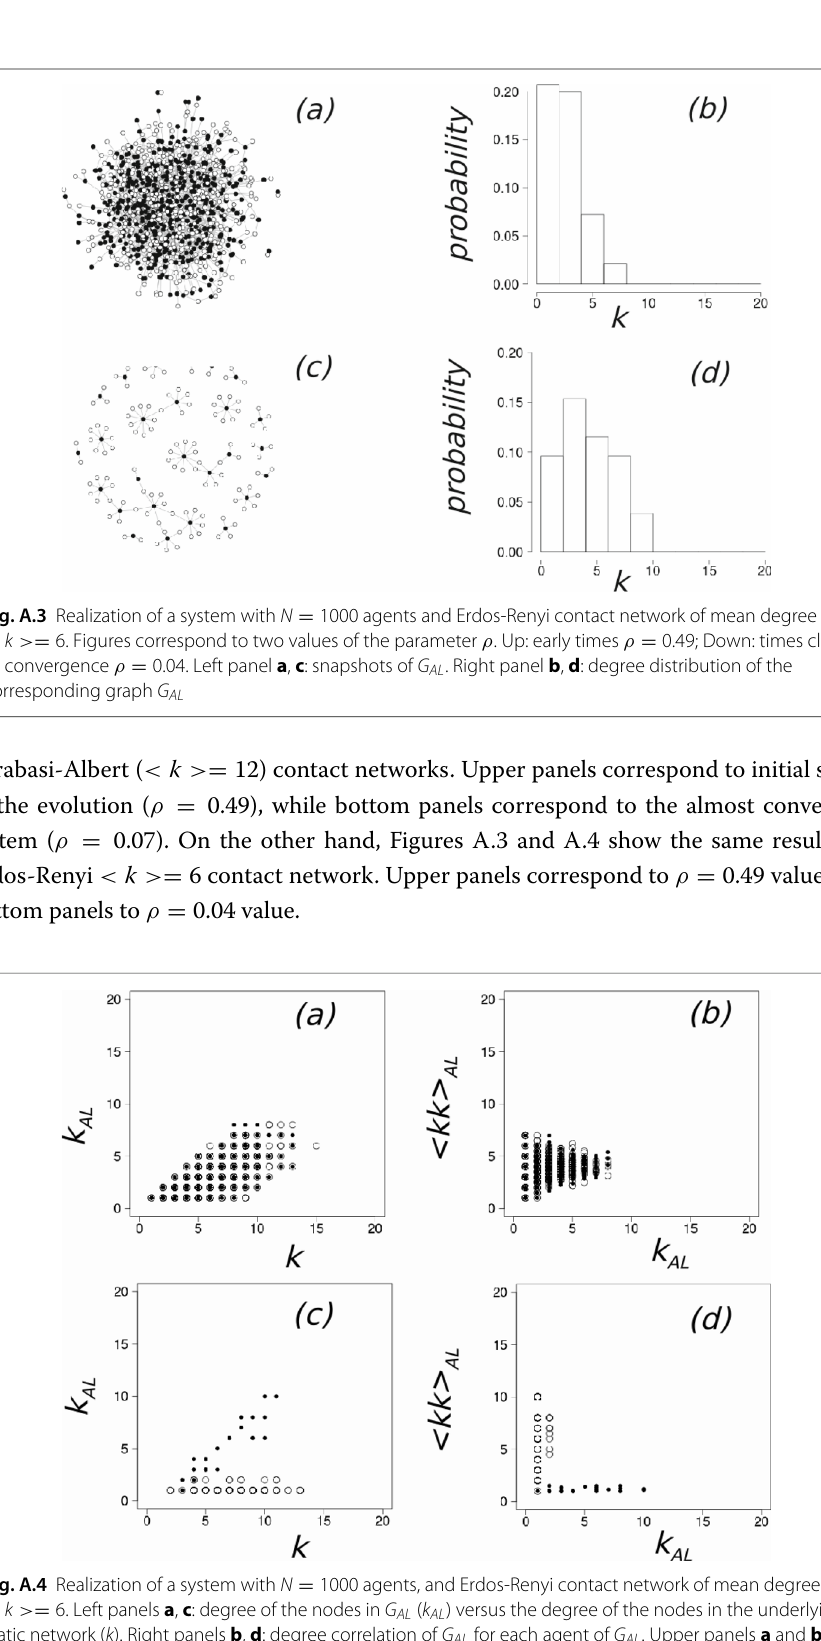
Fig. A.4 Realization of a system with N = 1000 agents, and Erdos-Renyi contact network of mean degree < k > = 6. Left panels a , c : degree of the nodes in G AL ( k AL ) versus the degree of the nodes in the underlying static network ( k ). Right panels b , d : degree correlation of G AL for each agent of G AL . Upper panels a and b correspond to ρ = 0.49. Lower panels c and d correspond to ρ =